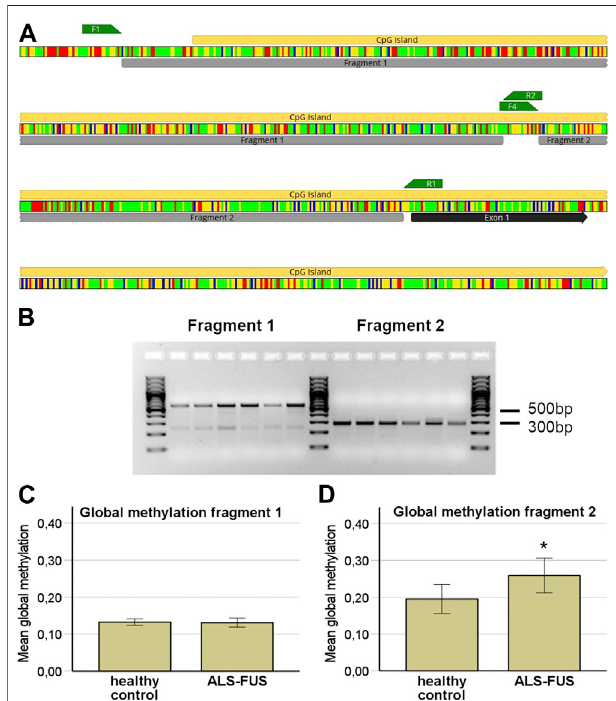
FIGURE 3 | Bisul fi te Sequencing of the FUS promoter, (A) In silico bisul fi te modi fi ed DNA sequence of the FUS promoter region. Colors represent DNA bases; Adenine: red, Cytosine: blue, Guanine: yellow, Thymine: green. Bisul fi te sequencing primers: F1 forward and R2 reversed primer for fragment one and F4 forward primer and R1 reversed primer for fragment 2, (B) Gel electrophoresis of the two bisul fi te sequencing fragments of the FUS promoter, (C) Global FUS promoter methylation independentofdifferentiationstatusshowednosigni fi cantdifferencebetween cell lines in fragment 1, (D) ALS cell lines display a signi fi cant higher mean global methylation in fragment 2 (independent samples t -test; p < 0.05, n (cid:2) 3 per condition and n (cid:2) 3 per cell